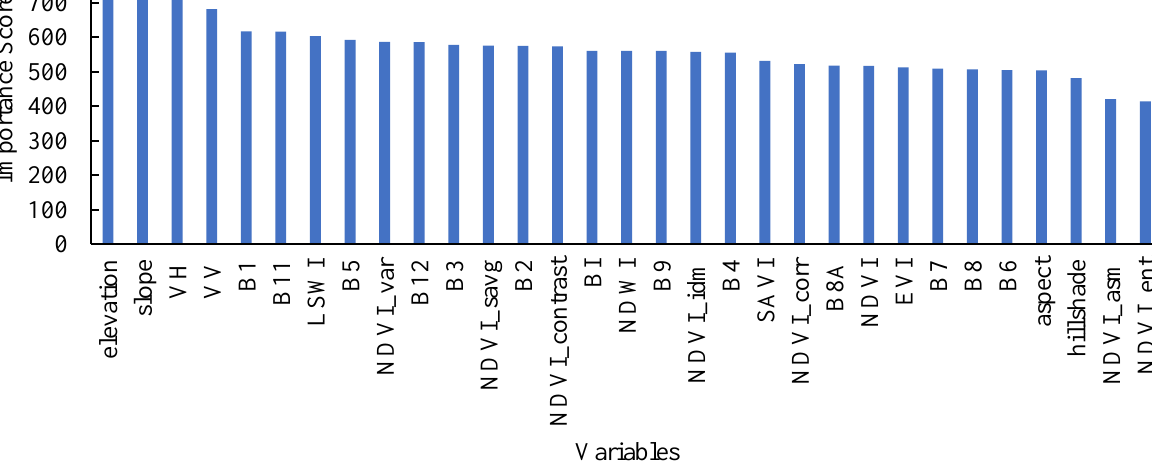
A comparison of the overall classification accuracies of the different classifiers when different feature variables were inputted is shown in Figure 5. It can be seen that the OA of the same classifier was different when different feature variables were involved in the classification. For the SVM, in addition to the texture features, the participation of other feature variables improved the value of OA. In particular, the participations of spectral indices and radar features significantly improved the OA of SVM classifier, with a value of 0.76% and 1.33%, respectively. The SVM classifier had the highest OA when the spectral bands, spectral indices, terrain features, and radar features participated in the classification at the same time, with an OA of 95.65% and a Kappa coefficient of 0.93. The participations of each type of feature variables increased the OA of the classification results when CART and RF were used for classifications, respectively. They both reached the highest value